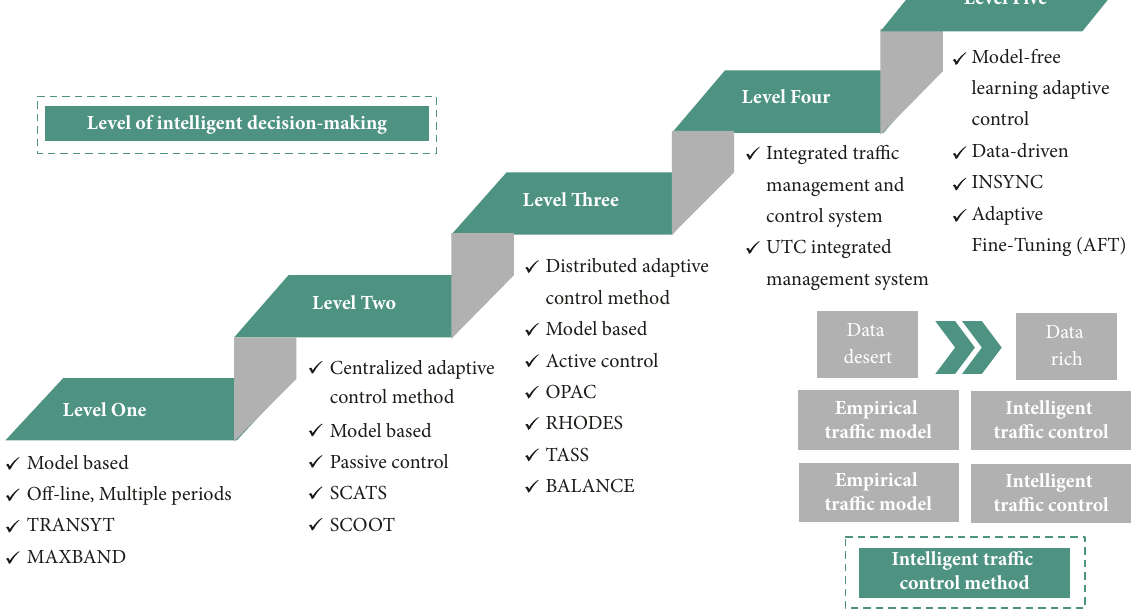
Figure 2: Urban traffic self-adaptive control system development process